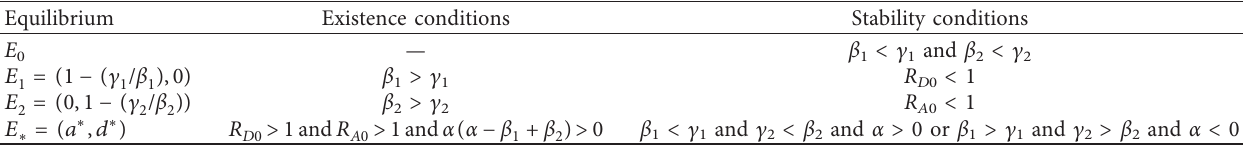
Table 2: Summary of sufficient existence and stability conditions of equilibria.